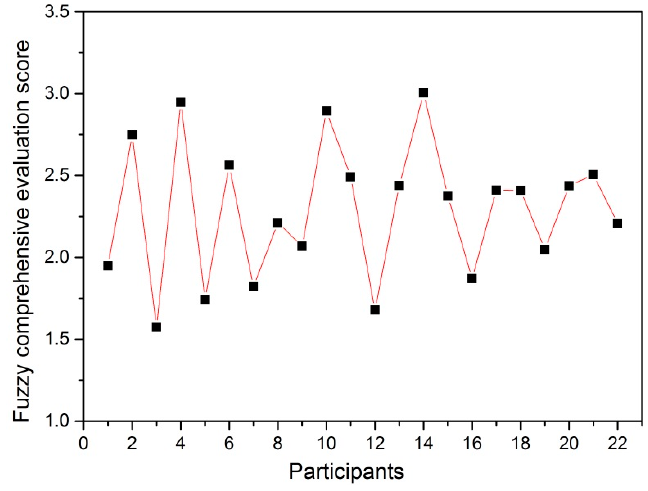
Figure 2. The evaluation score of all